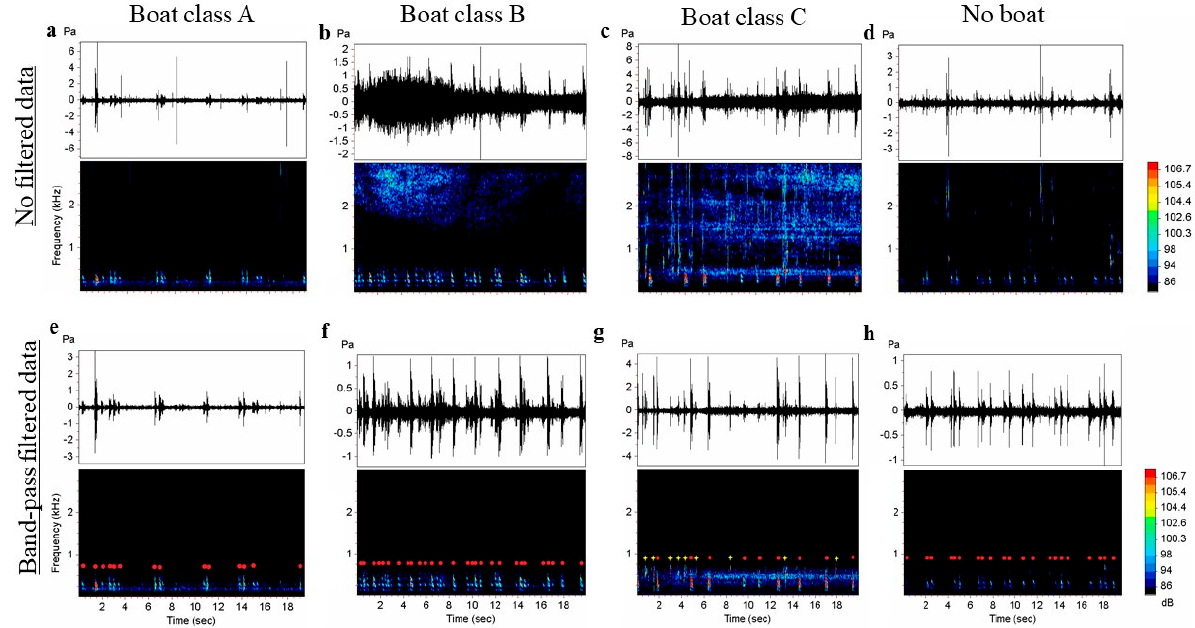
Figure 3. Spectrograms (FFT size = 512, Hamming windows) and waveform of 20 s of recording subsampled at 3 kHz, with black drum calls during Class A boat noise, Class B boat noise, Class C boat noise, and no boat noise without a band filter (from ( a ) to ( d )) and 0.1–0.7 kHz of band ‐ pass filtering (from ( e ) to ( h )). Red dots indicate calls correctly counted by automatic pulse train analysis; yellow stars indicate signals wrongly detected by automatic counting and excluded by visual inspection.